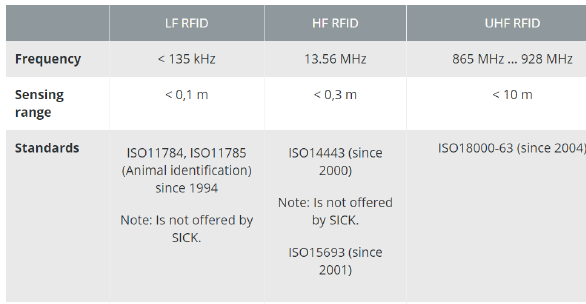
Table 2: Allowed frequency operation range for a RFID TAG and related standard The WSN (Wireless Sensor Network) was designed using active and passive RFID sensors from FARSENS [33] operating in the UHF frequency range, autonomous sensors already presented by